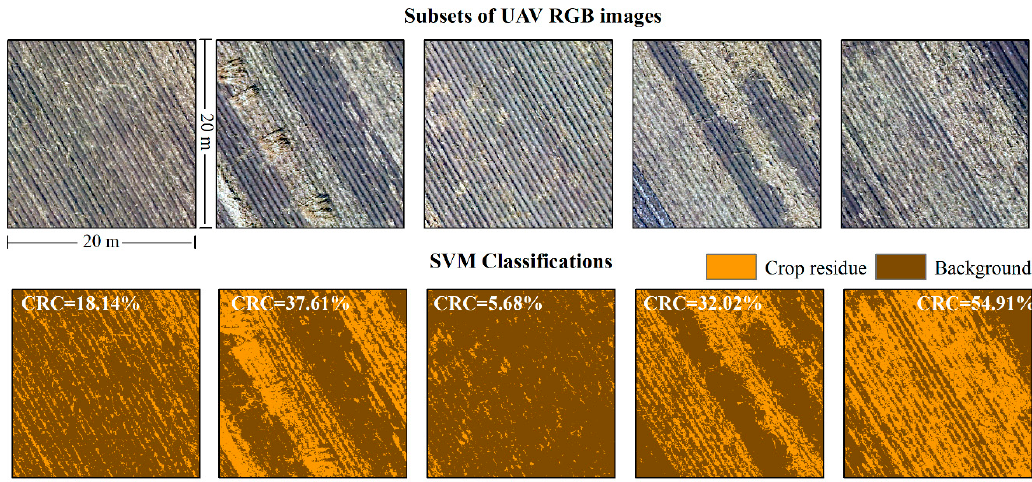
Figure 3. Examples of support vector machine (SVM) classification results. The upper figures are subsets of UAV mosaic and the lower figures are corresponding classifications. Table 2. Confusion matrix for the SVM classification with validating data (number of pixels = 5900).